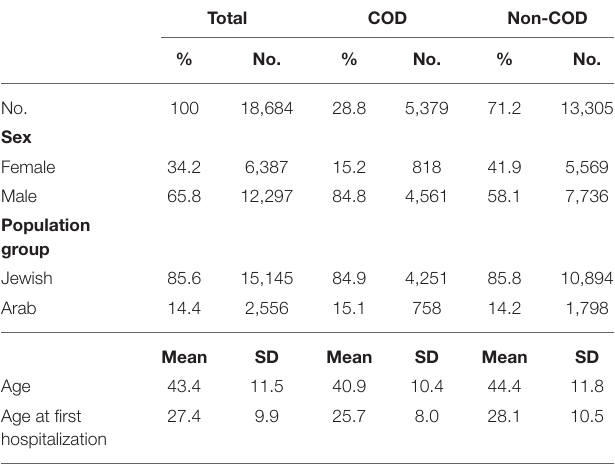
TABLE 1 | Demographic characteristics of people with schizophrenia/schizoaffective disorder (aged 18–65) with a psychiatric hospitalization during the period 1963–2016, by co-occurring SUD status, Israel.